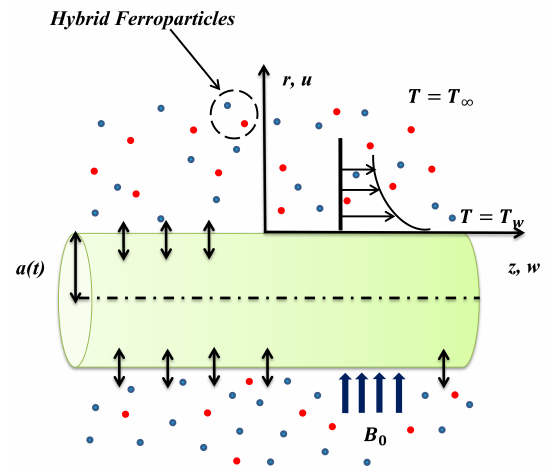
Figure 1. Diagrammatic portrayal of the